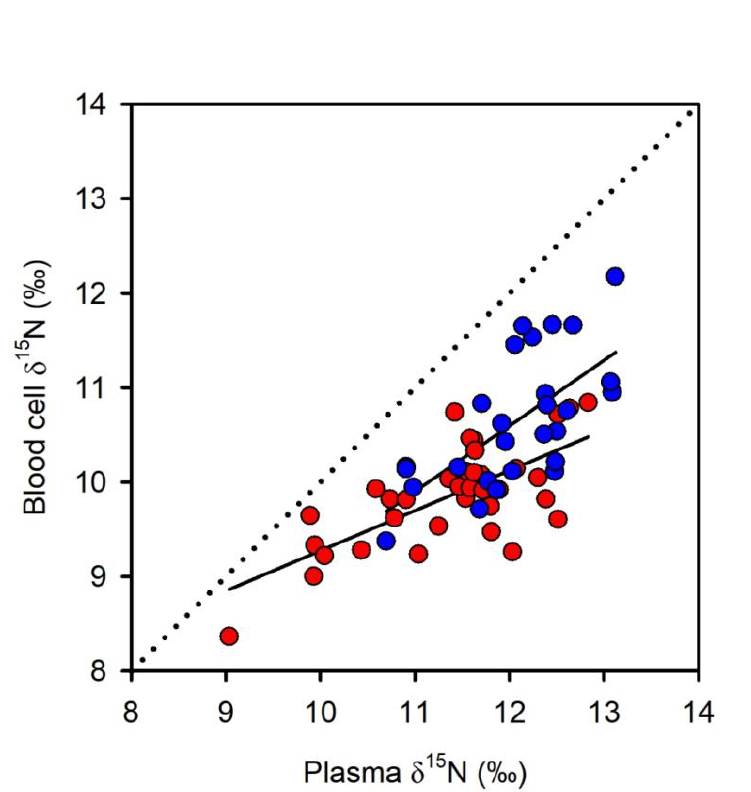
Figure 5. Relationships between blood cells and plasma  15 N values for male (n = 27, blue) and female (n = 35, red) snow petrels sampled at Ile des Pétrels, Adélie Land, East Antarctica. Males: F 1,22 =15.203, P<0.001, R² = 0.409; females: F 1,20 =24.300, P<0.001, R² =